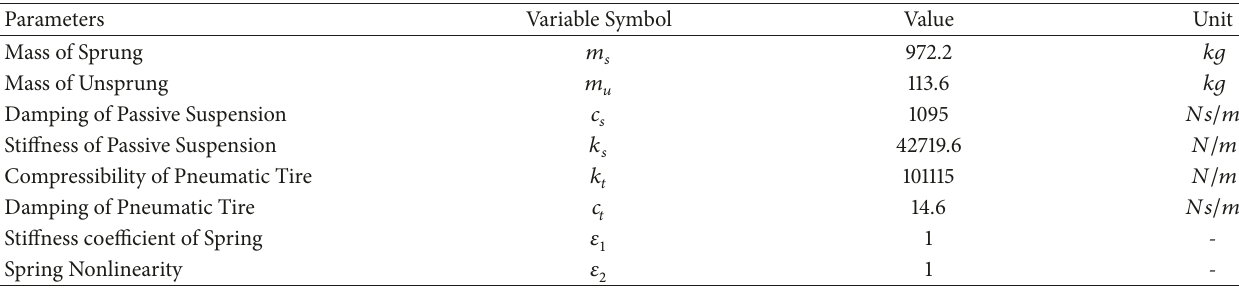
Table 1: Parameters of active vehicle suspension.